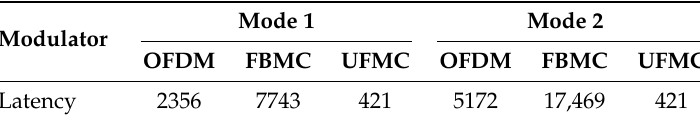
Table 2. Processing latency (in clock